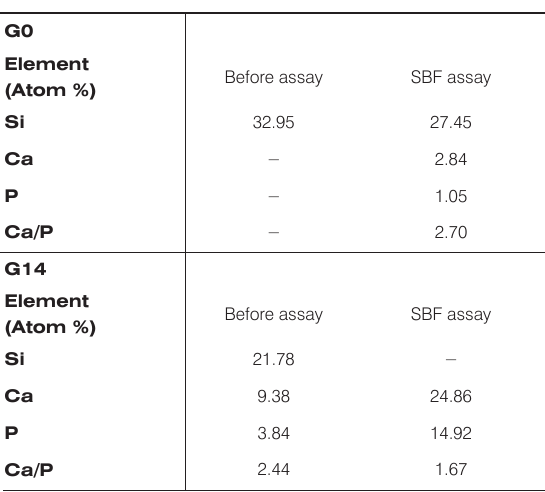
Table 3. Surface composition obtained by EPMA of glass samples before and after 7-day assay in